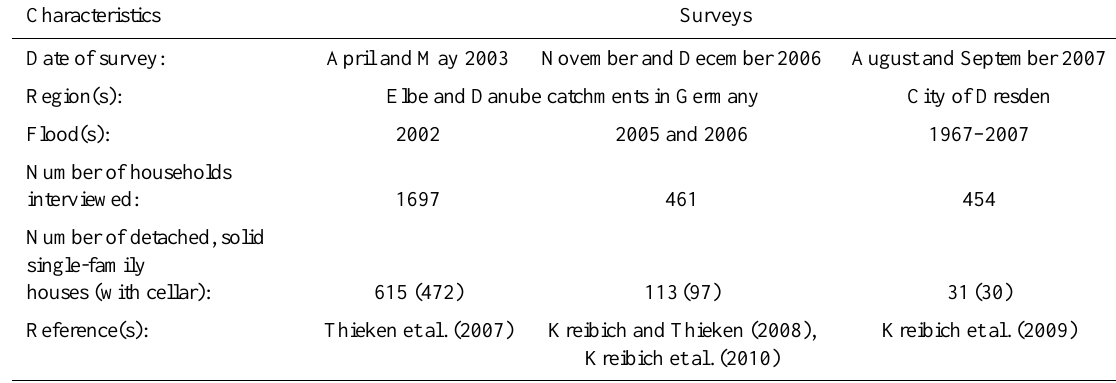
Table 1. Flood damage surveys: computer-aided telephone interviews with private households affected by flooding.